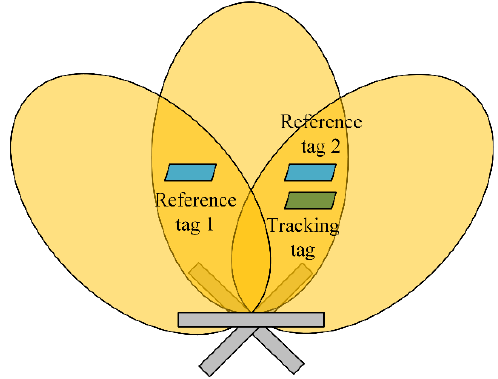
Figure 5. Flow chart of the NJW-based algorithm.